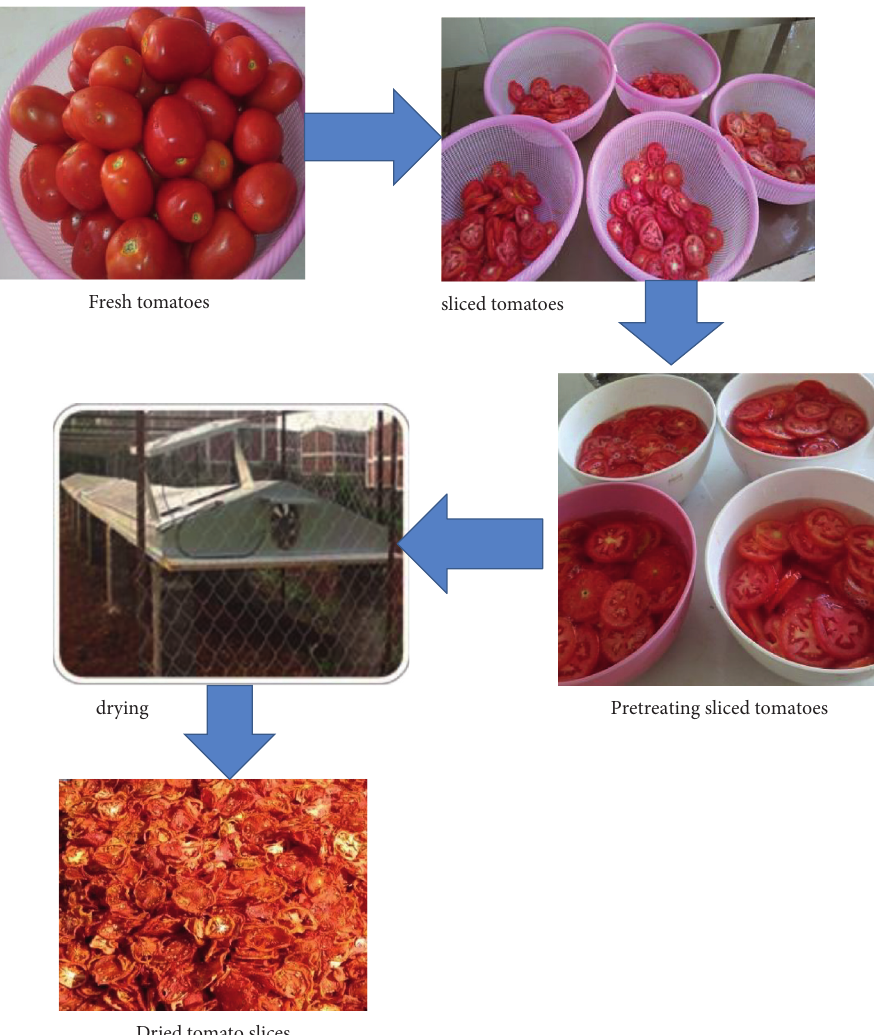
Figure 2: Process flowchart of tomato drying with predrying treatments.